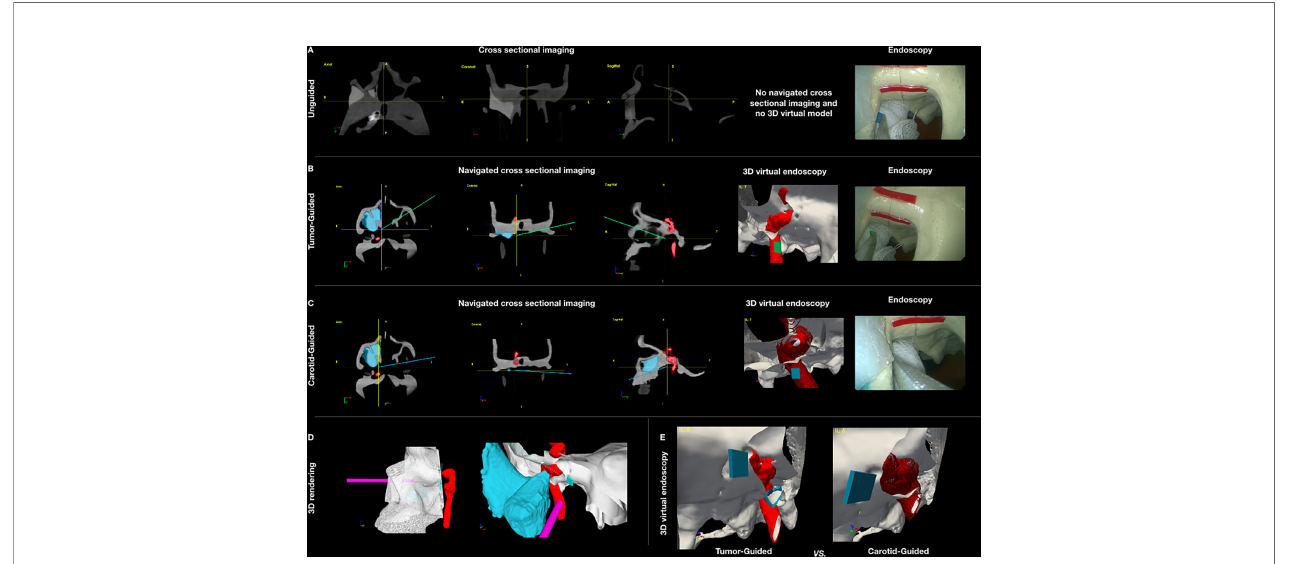
FIGURE 3 | (A – C) Panel showing the appearance of the different settings of data acquisition: unguided simulations with cross-sectional imaging pre-simulation analysis (A) , tumor-guided (B) , and carotid-guided (C) simulations with real-time surgical navigation indicating the position of the instrument and the posterior margin delineation. (D) Pictures showing the appearance of the 3D rendering of the skull with the positions of the scope and pointer. Virtual margin delineation, simulating the cut of 3D objects (skull, tumor, and carotid). (E) Comparison of the 3D virtual endoscopy appearance in the tumor-guided and carotid-guided